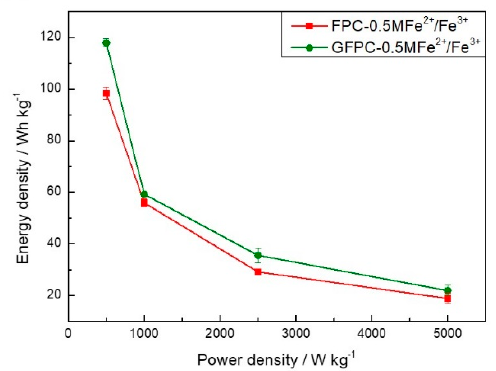
Figure 7. Ragone plots of FPC and GFPC symmetric SCs in a 1 M H 2 SO 4 + 0.5 M Fe 3+ /Fe 2+ electrolyte.